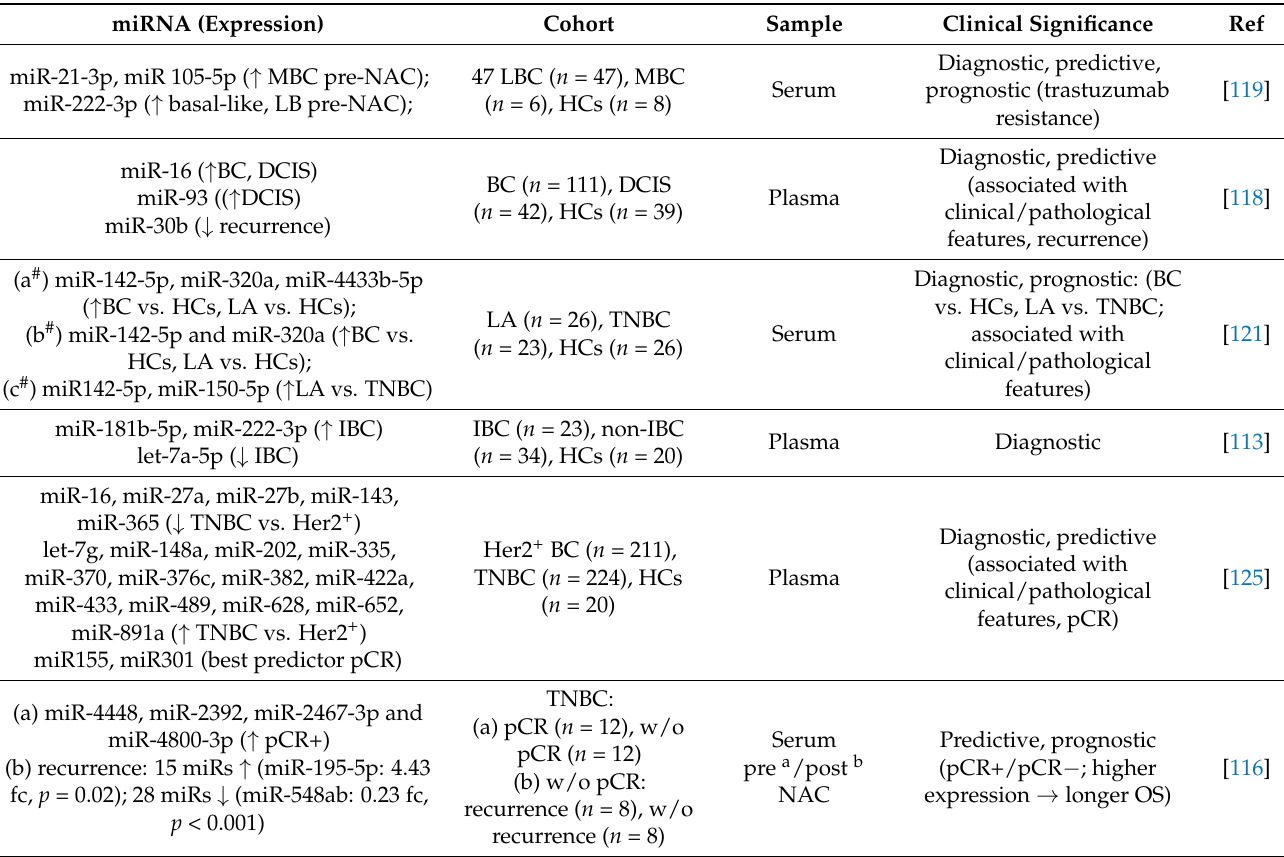
Table 2. EV-miRNAs as potential diagnostic, predictive and prognostic biomarkers. miRNA (Expression) Cohort Sample Clinical Significance Ref